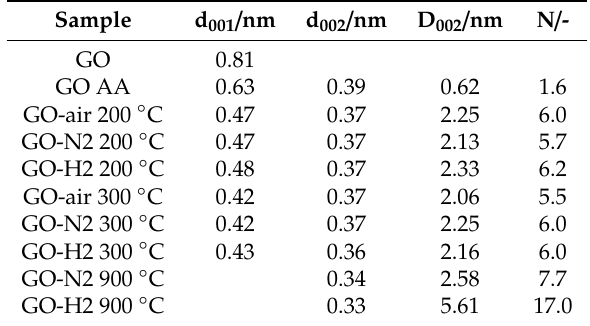
Table 2. Di ff erent properties of the samples calculated from XRD